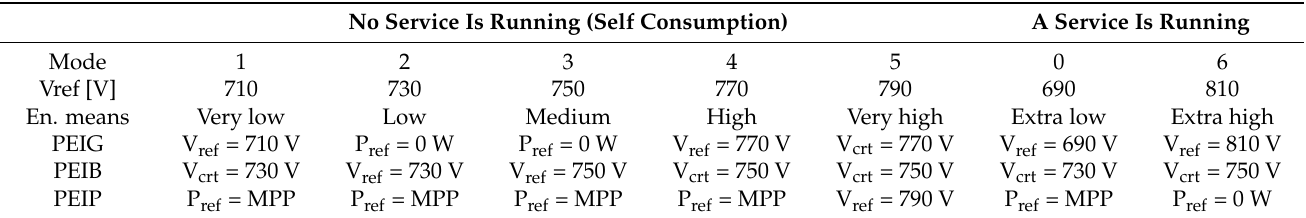
Figure 4. DBS modes and the corresponding voltage references. Table 1. DBS parameters: voltage references for the DC bus and voltage controls for power